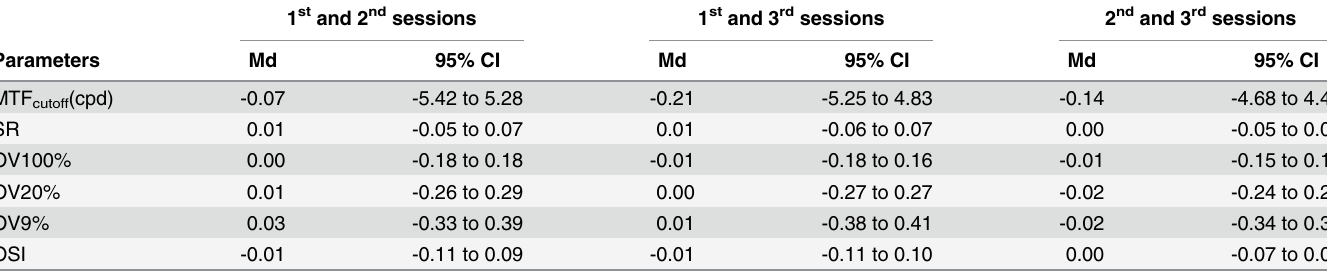
Table 3. Bland and Altman analysis for intersession repeatability between